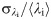
Maps of the DTI parameters in the crossing-fibre phantom.Eigenvalues λi, i = 1,2,3 (a) and metrics MD (b) and FA (c) for the unmatched case (top) and the matched case (bottom). Two angular orientations are shown: θ = 0° on the left-hand side, and θ = 45° on the right-hand side. The angular dependence for the ROI-averaged values for 〈λi〉 (d), 〈MD〉 (e) and 〈FA〉 (f). The corresponding normalised standard deviation values σλi/〈λi〉 (g), σMD/〈MD〉 (h) and σFA/〈FA〉 (i), for the unmatched (black-solid lines) as well as for the matched (red-dashed lines) cases.